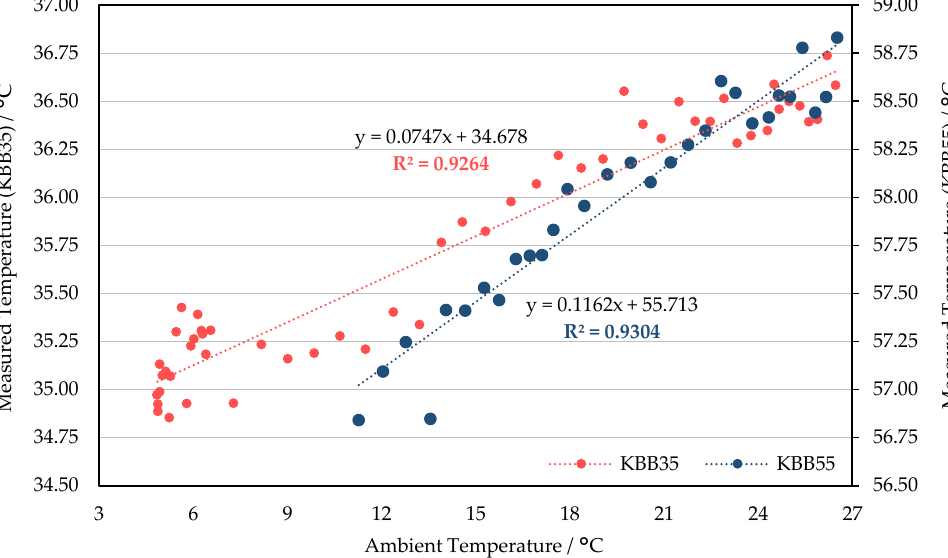
Figure 8. The correlation between the measured temperature by FLIR E8-XT and the ambient temperature. This session was conducted at the blackbody temperature of 35 °C (KBB35) and 55 °C (KBB 55), separately. P-value was smaller than 0.001 for both.